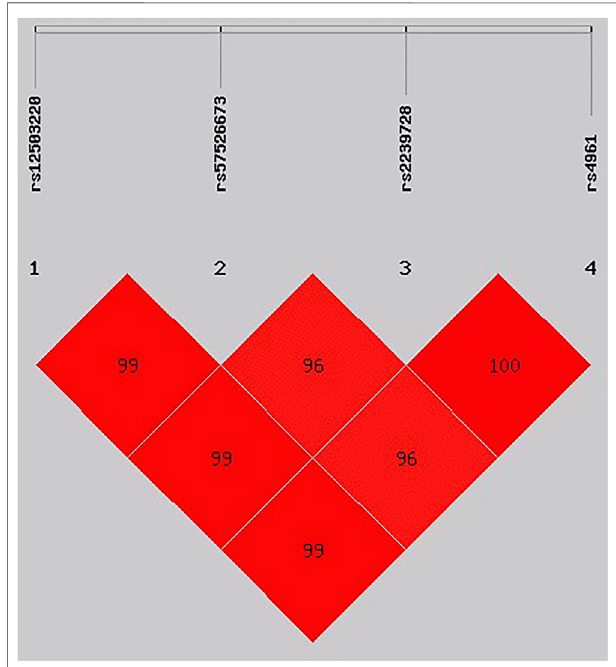
FIGURE 1 | We used the parameters r2 and D ′ ’ to analyze the linkage disequilibrium (LD) of the SNPs on ADD1. Signi fi cant LD is indicated by bright red standard colors.